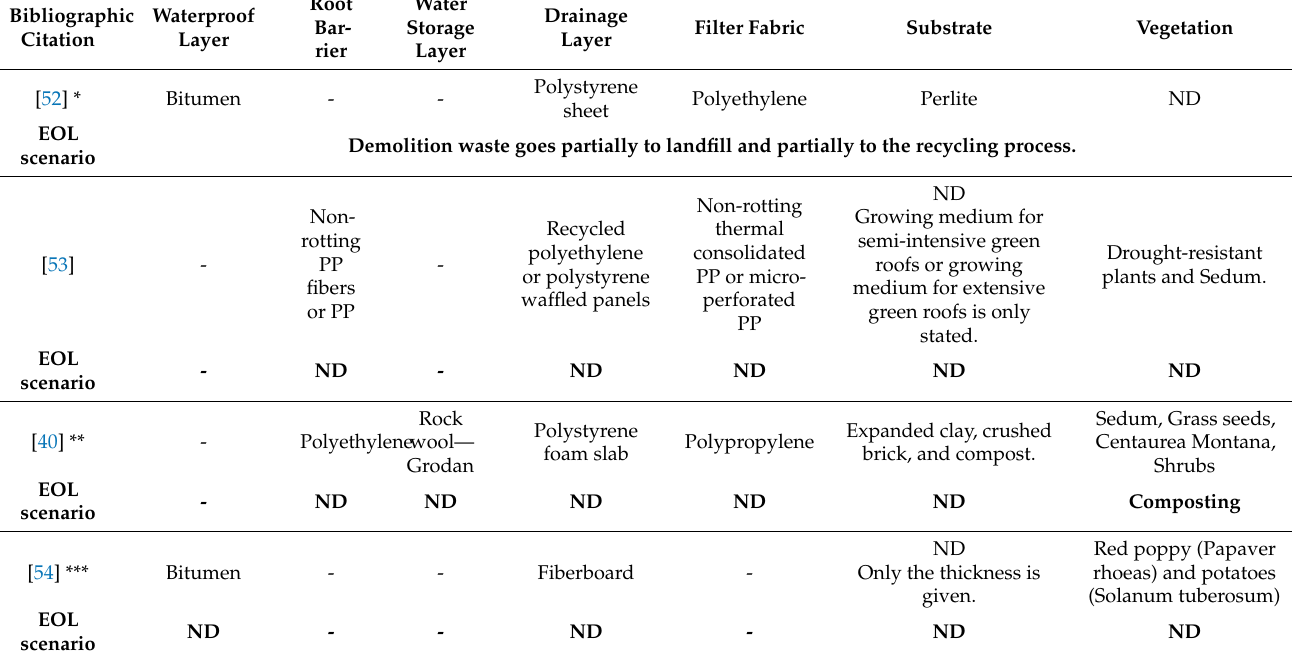
Table 8. End-of-life (EOL) scenarios of green roofs and criteria/procedures to define the presented EOL scenarios, reported in the four selected review papers (ND = not declared in the article).